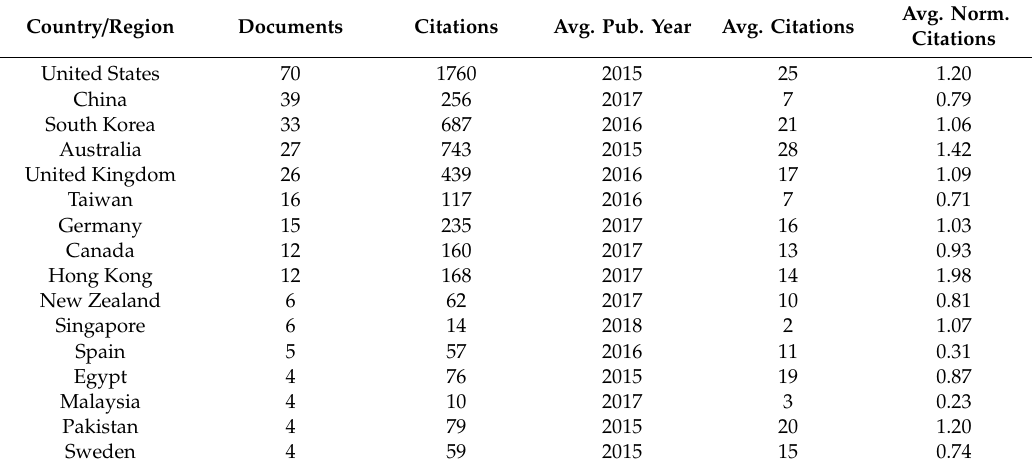
Table 2. Details of countries/regions.